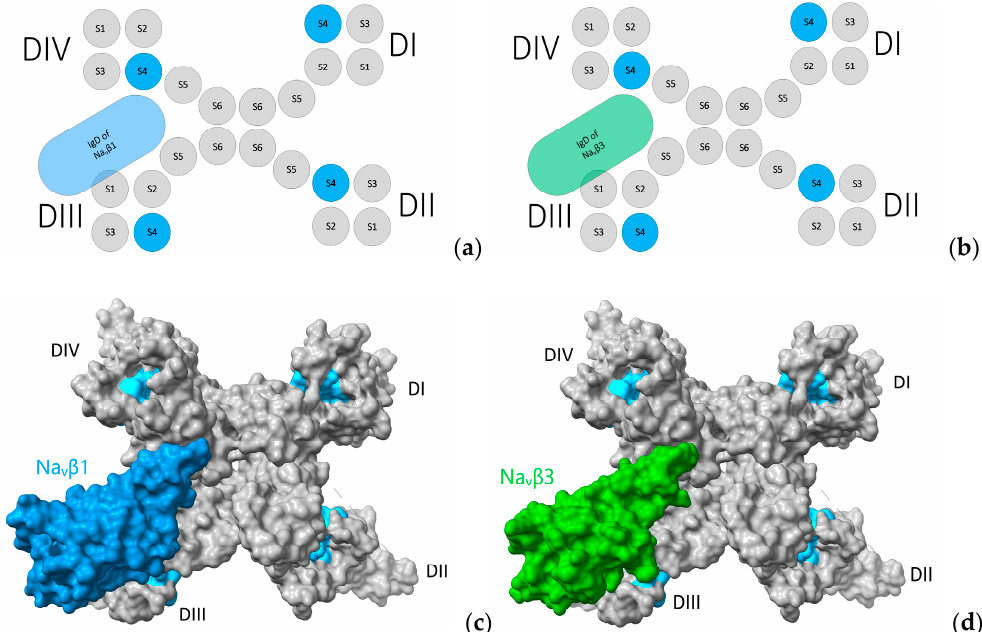
Figure 9. Three-dimensional ( 3D) location of subunits Na v β 1 and Na v β 3. ( a , b ) Na v α topology in complex with Na v β 1 and Na v β 3. Display of 3D models with solvent-excluded surface areas in panels ( c , d ). ( c ) Cryo-EM structure of hNa v α 1.4 in complex with Na v β 1 [49] and ( d ) Cryo-EM structures of hNa v α 1.4 [49] in complex with crystal structure hNa v β 3 [55] positioned according to structural analysis; S4: sky blue; in panels ( c , d ) the molecular surfaces are colored: Na v β 1: cornflower blue; Na v β 3: green forest; and grey color for Na v α subunit surfaces. The same colors were applied to the panels ( a , b ) above. 3D models by Chimera X [65].